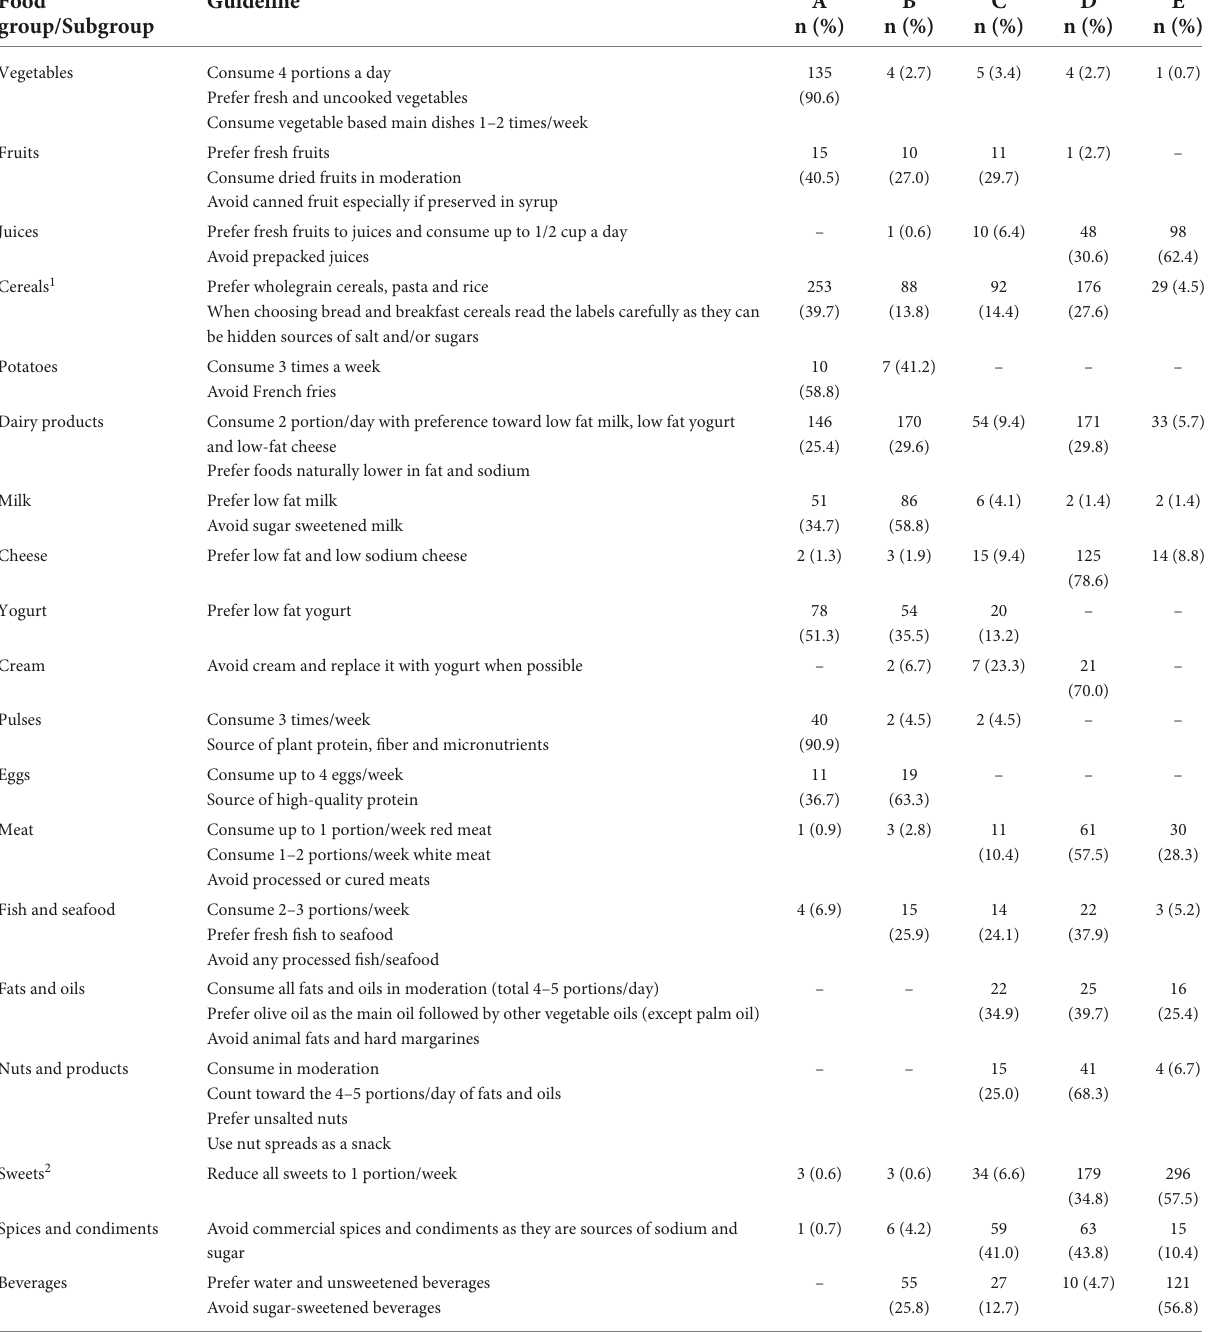
TABLE 3 Presentation of Greek food-based dietary guidelines for adults (21) per food group/subgroup and the relevant distribution of Nutri-Score calculated for the branded food products of the Hellenic food thesaurus (HelTH) branded food composition databases (BFCD) ( n = 3,224). Food